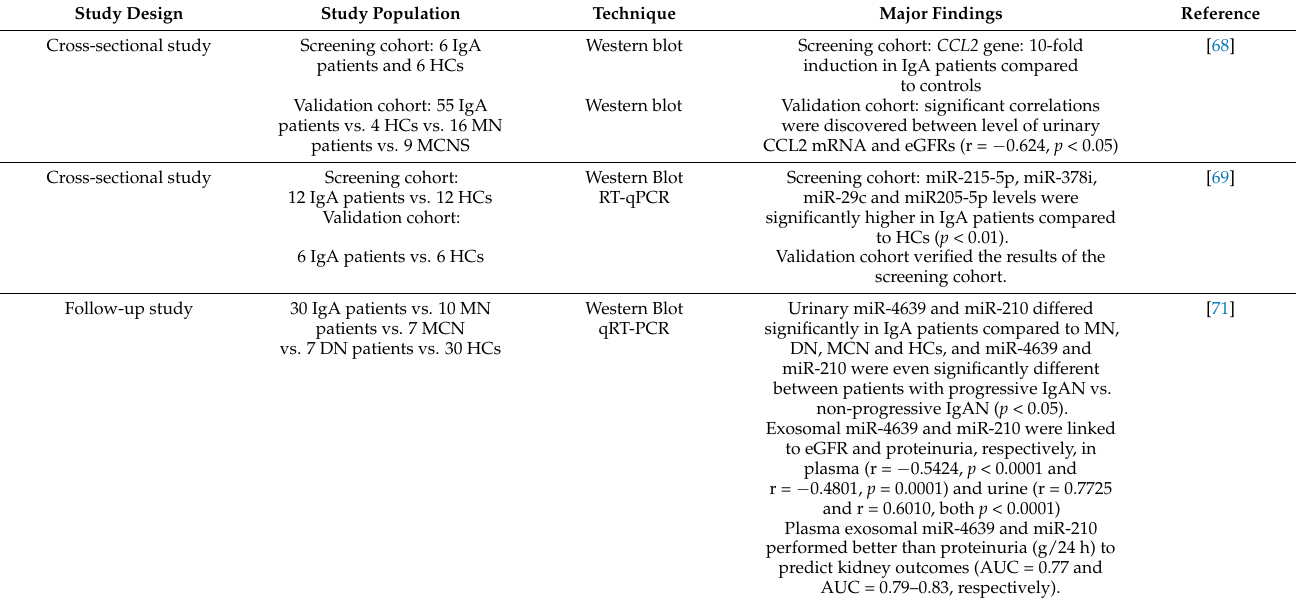
Table 2. Overview of studies of urinary extracellular vesicles in IgA nephropathy. HCs: